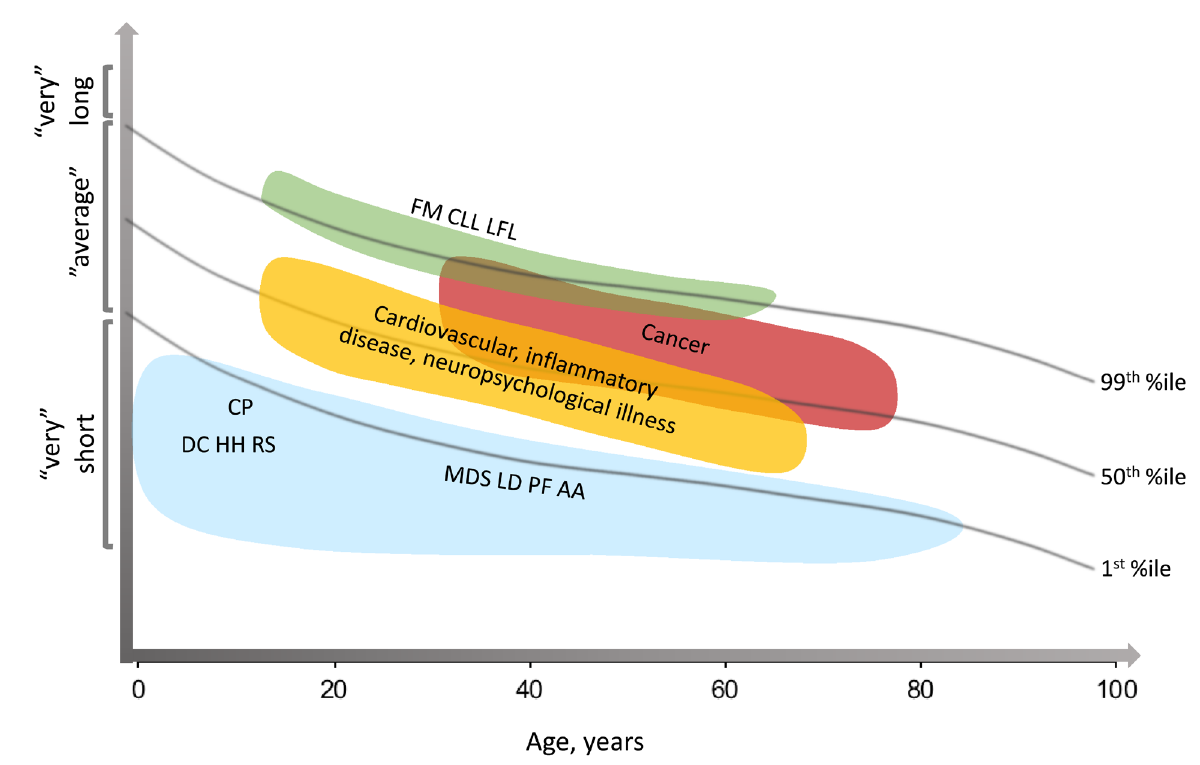
Figure 4. Schematic representation of the connections between age, telomere length, and human disease. Clinically significant telomeres associated with telomere biology disorders are generally at or below the first percentile for age (blue shape). Many association studies of telomere length and human phenotypes, including cancer, have identified statistically significant, but perhaps not clinically significant, differences in telomere length between cases and controls (represented by yellow and red). Some studies have identified rare families with germline mutations in components of the shelterin telomere protection complex as associated with longer telomeres (green shape). AA, aplastic anemia; CLL, chronic lymphocytic leukemia; CP, Coats plus; DC, dyskeratosis congenita; FM, familial melanoma; HH, Hoyeraal Hreidarsson syndrome; LD, liver disease; LFL, Li-Fraumeni-like syndrome; MDS, myelodysplastic syndrome; PF, pulmonary fibrosis; RS, Revesz